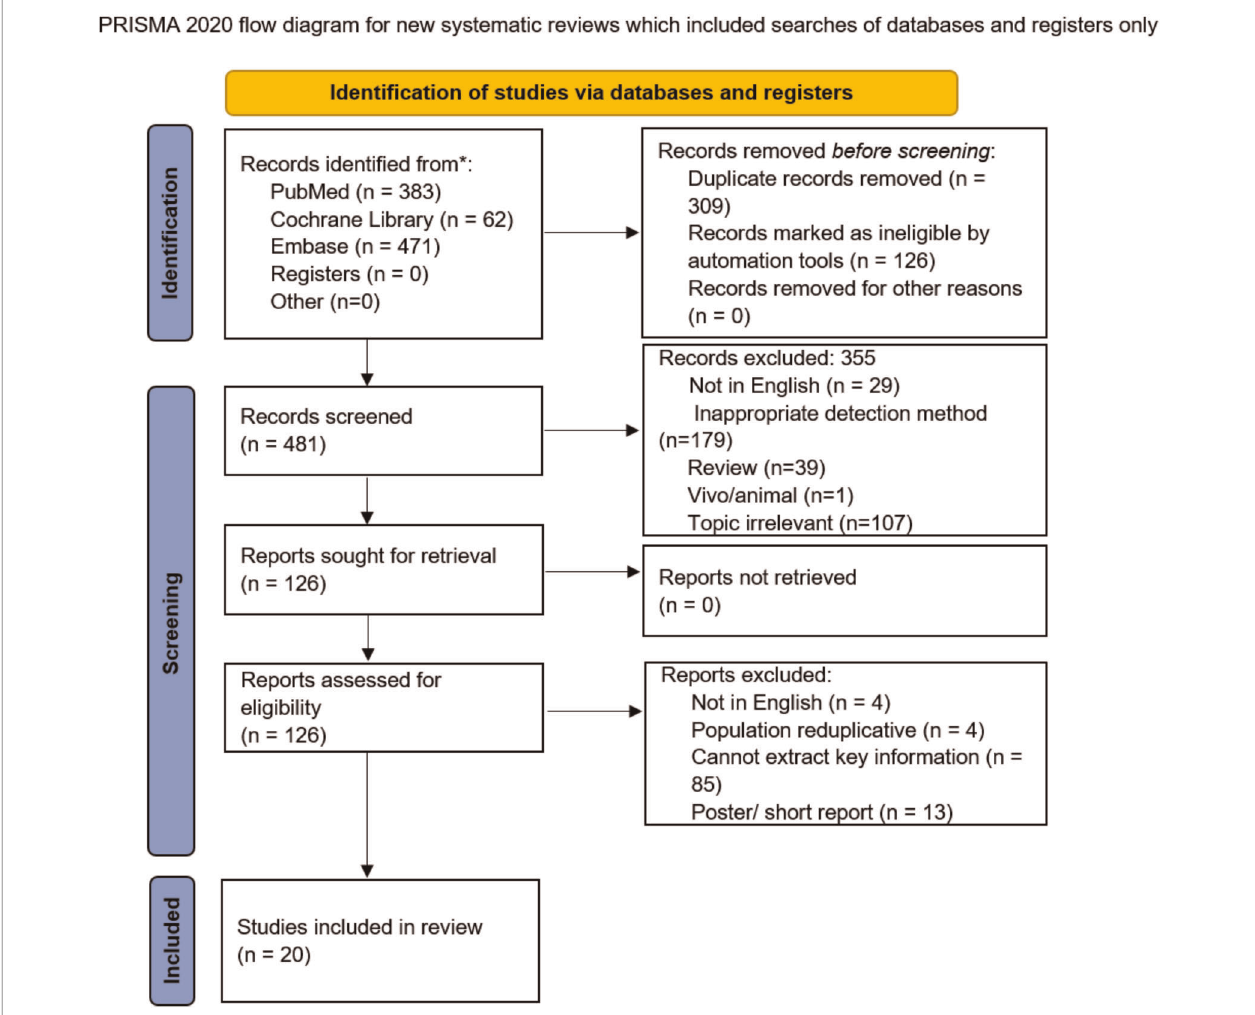
FIGURE 1 | Flow chart of the study selection